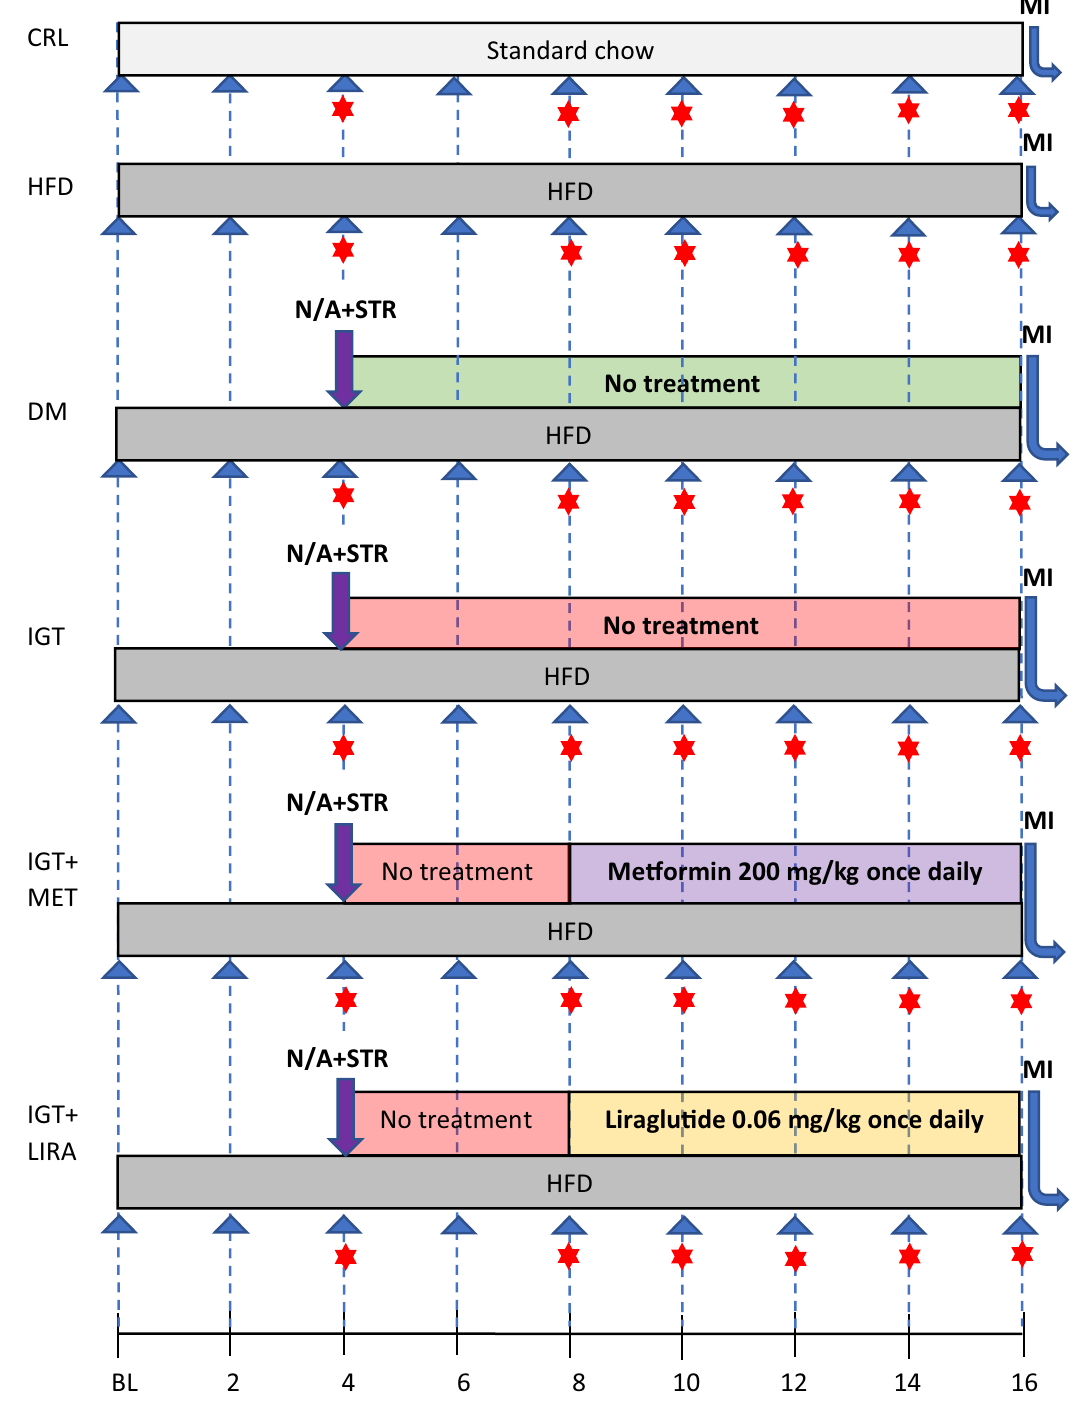
Figure 1. Study design. CRL (n = 6), control group; HFD (n = 8), high-fat diet group; DM (n = 4), type 2 diabetes mellitus group; IGT (n = 4), impaired glucose tolerance group; IGT + MET (n = 4), impaired glucose tolerance + metformin group; IGT + LIRA (n = 4), impaired glucose tolerance + liraglutide group; N/A, nicotinamide; STR, streptozotocin; MI, myocardial infarction modelling; BL, baseline; blue filled triangle, body weight and food consumption measurement; red filled star, blood glucose